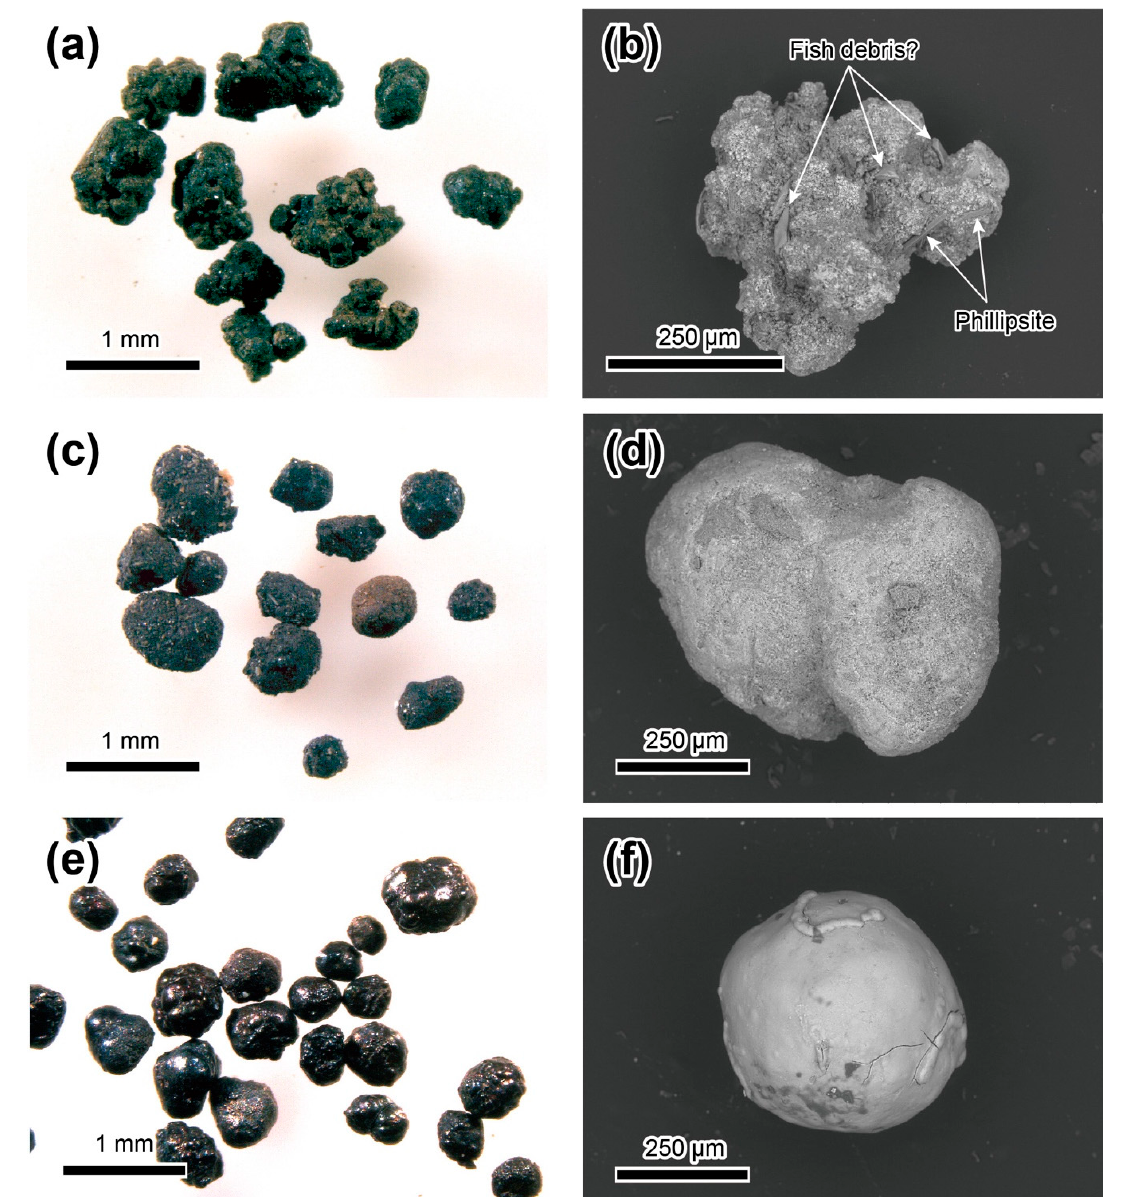
Figure 8. Photomicrographs taken with a stereomicroscope and scanning electron microscope images of representative Fe–Mn micronodule grains. ( a ) Visual appearance and ( b ) backscattered electron (BSE) images of B-type micronodules. The samples were taken from ( a ) MR14-E02 PC05, section 1, 4–6 cm (0.05 m below the seafloor, mbsf; from [37]) and ( b )